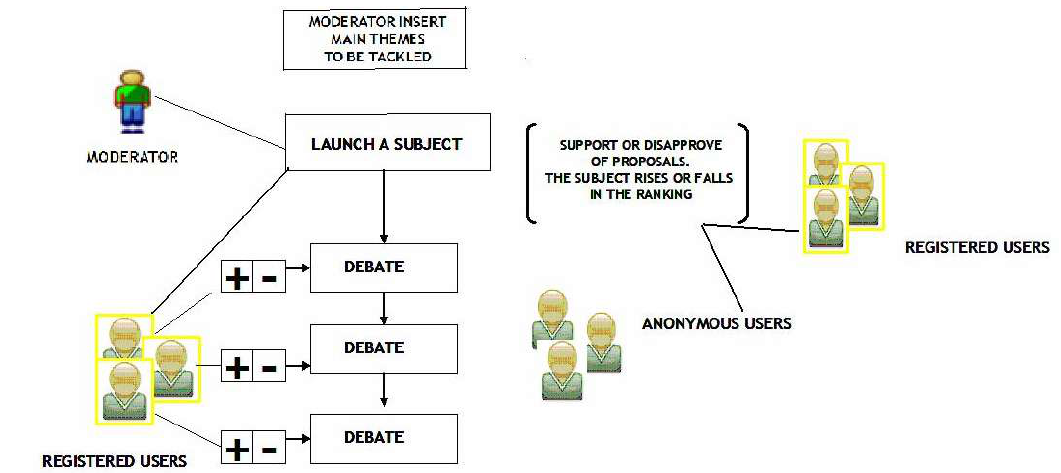
Figure 5: User roles on the IDEAL-EU SNP In short, each debate on the SNP was made up of three